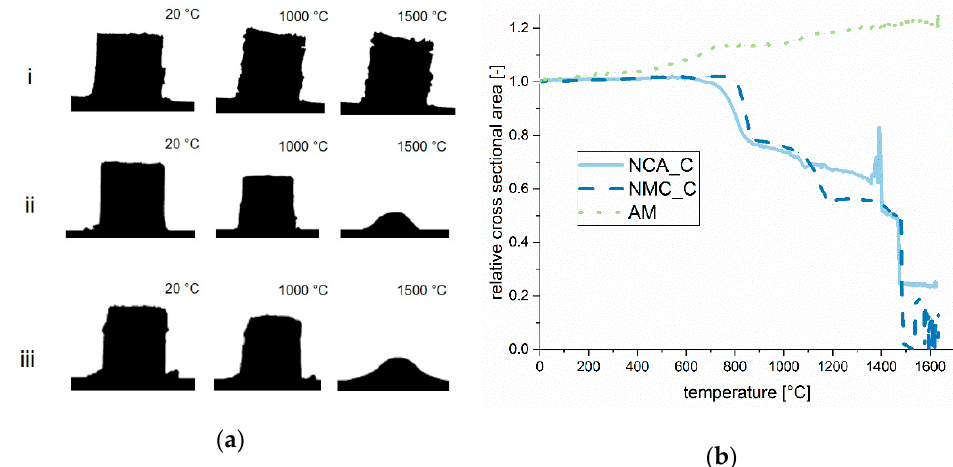
Figure 5. ( a ) Images of the samples AM (i), NMC_C (ii) and NCA_C (iii) at temperatures of 20 °C, 1000 °C and 1500 °C taken during the heating microscope experiments; ( b ) Trend of the cross sectional area of the samples AM, NMC_C and NCA_C during heating in the heating microscope.